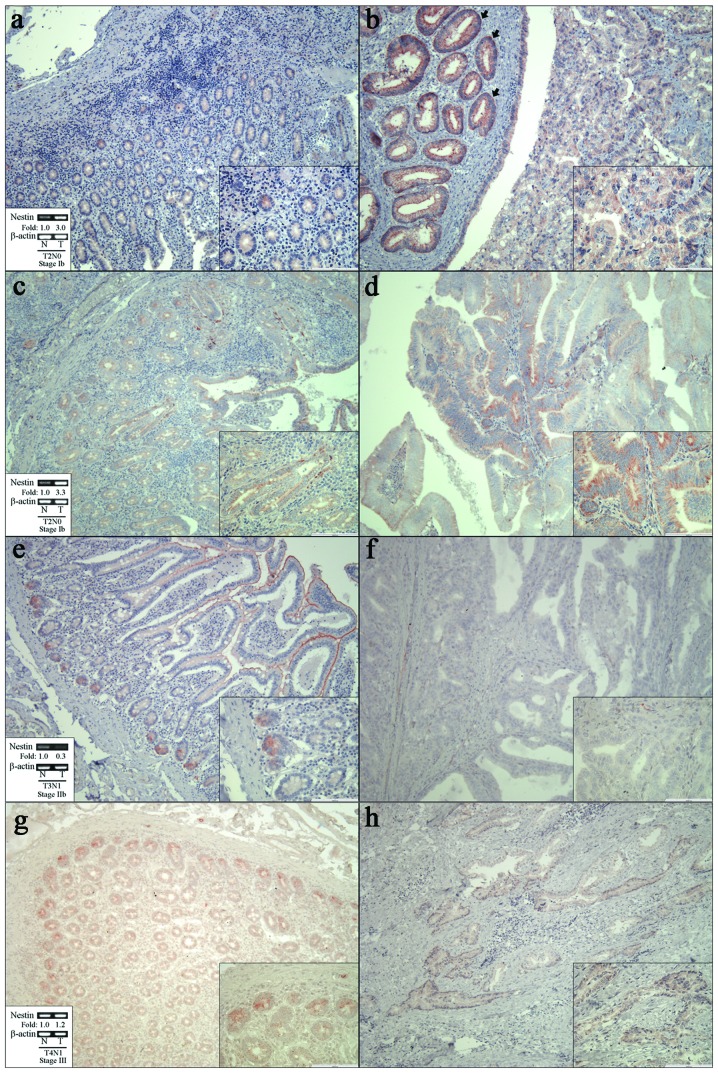
Expression of nestin in ampullary adenocarcinoma by immunohistochemistry (IHC) staining. The main images were captured at ×100 magnification and the small images located at the right lower quadrant of each figure were captured at ×400. (a, c, e and g) The boxes at the left lower quadrant contain the semi-quantitative results of RT-PCR. (a, c, e and g) Expression of nestin protein in normal duodenum and (b, d, f and h) ampullary adenocarcinoma. (a and c) Weak expression of nestin in normal duodenal mucosa and (b and d) strong or mild expression of nestin in T2N0, stage IB ampullary adenocarcinoma of the same patient. (b) Strong expression of nestin in adjacent adenoma is shown to the left side of the arrows. (e) Weak expression in normal duodenal mucosa and (f) negative expression in T3N1, stage IIB ampullary adenocarcinoma. The nestin mRNA is downregulated in stage IIB cancer (T3N1) in RT-PCR (Fig. 1a) and (f) immunoreactivity of nestin is nearly undetectable in cancer with (e) preservation in normal duodenum. (g) Weak expression in normal duodenal mucosa and (h) weak expression in T4N1, stage III ampullary adenocarcinoma. The IHC results in T4N1 disease revealed equal density of nestin in cancer and normal duodenum, which was the same as the results in RT-PCR. Expression of nestin protein in IHC staining was correlated with detection of nestin mRNA in RT-PCR.